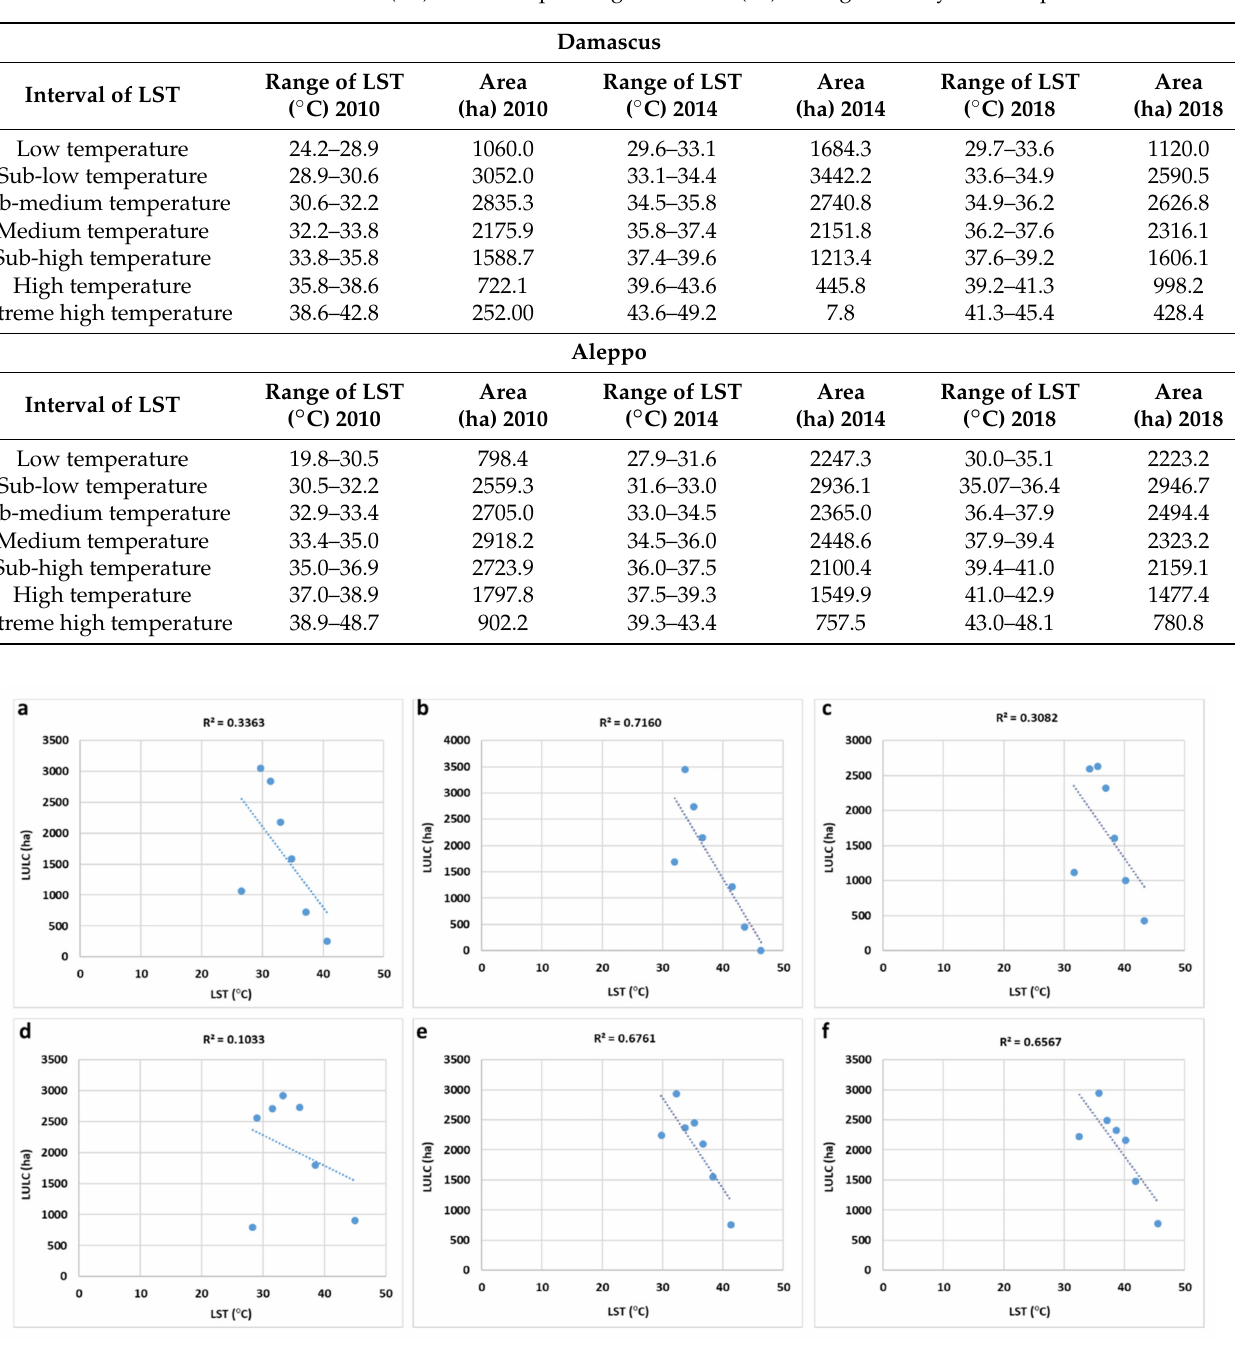
Figure 6. Linear regression analysis between the LST ranges (mean in ◦ C) and the size of the corresponding LULC for Damascus in 2010 ( a ), 2014 ( b ), and 2018, ( c ) and for Aleppo in 2010 ( d ), 2014 ( e ), and 2018 ( f